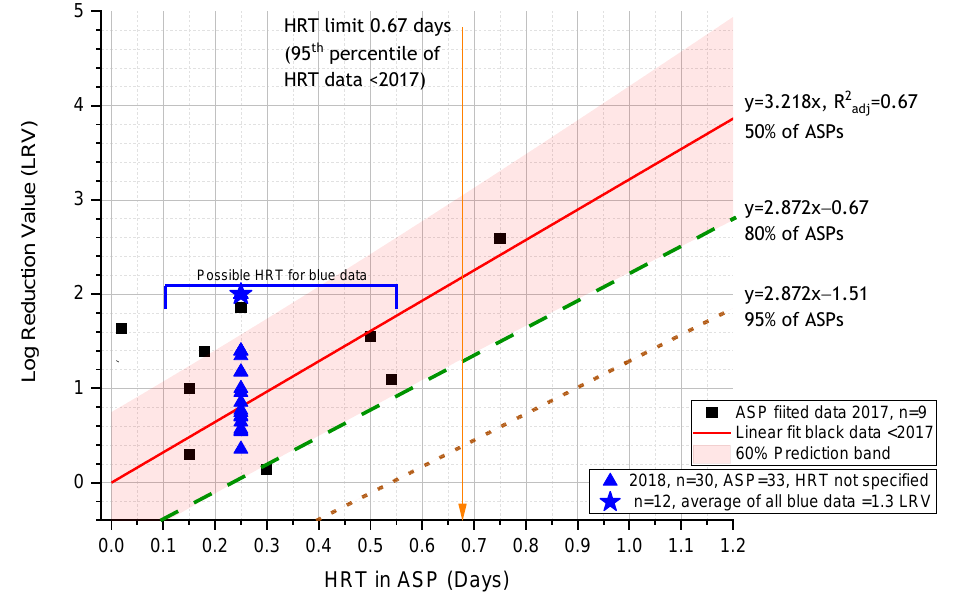
Figure 3. Log reduction value (LRV) design equation proposed for Activated Sludge Plants (ASPs). The green long-dashed line represents what 80% of ASPs would achieve (i.e., the lower 60% Prediction band) and is proposed for ASPs with a high level of design and management; data from [12]). The LRV equation for 95% of ASPs (red short-dashed line) was the removal equation originally proposed [12]. Blue data points are from the 2018 publications. Hydraulic retention time (HRT) limits are discussed in the text.